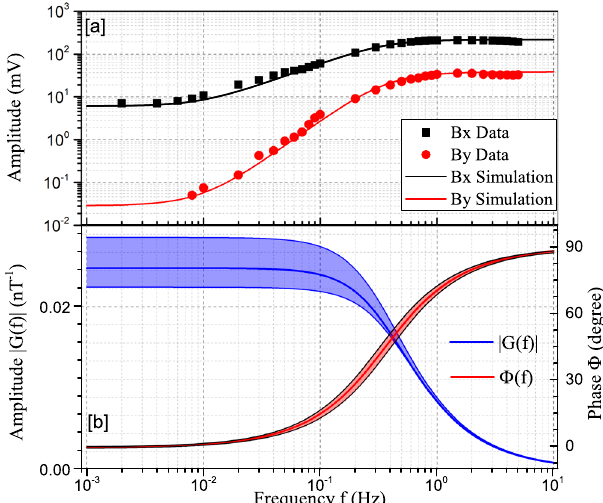
Fig. 7 | Frequency responses of the comagnetometer. a A comparison of the measuredfrequencyresponsestonormalmagnetic fi eldandthesimulatedresults. The simulated results are calculated with Eq.(7) based on measured parameters ( λ M e 0 P e z , λ M n 0 P n z , T 2 e and T 2 n )withonlyonefreeparametertodescribethescale.The measured data agree well with the simulation of the Bloch equation Eq. (7), which con fi rms the validity of the simulation. b The simulated amplitude-frequency response (blue) and phase-frequency response (red) to exotic fi eld b Ne y . The uncertainty bands of the phase and amplitude are calculated based on the uncer- tainties of the measured